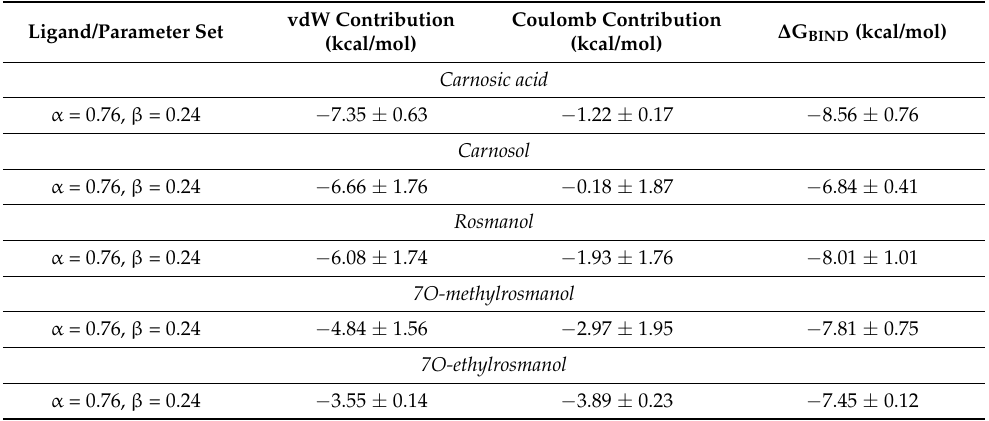
Table 1. The average electrostatic and van der Waals nonbonded contributions of carnosic acid, carnosol, rosmanol, 7O-methylrosmanol, and 7O-ethylrosmanol binding in the complex with HIV-1 protease, along with the corresponding binding free energies calculated using the LIE